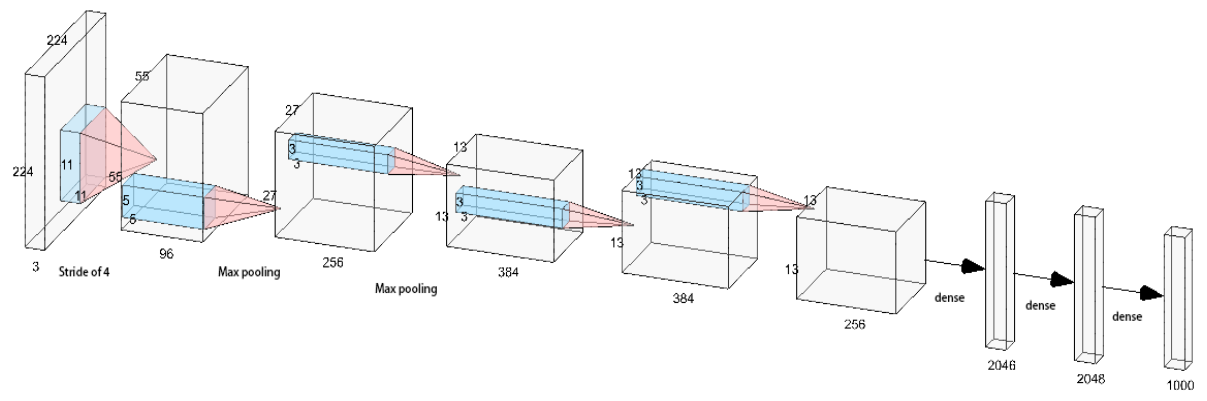
Figure 3. Schematic diagram of FCN.